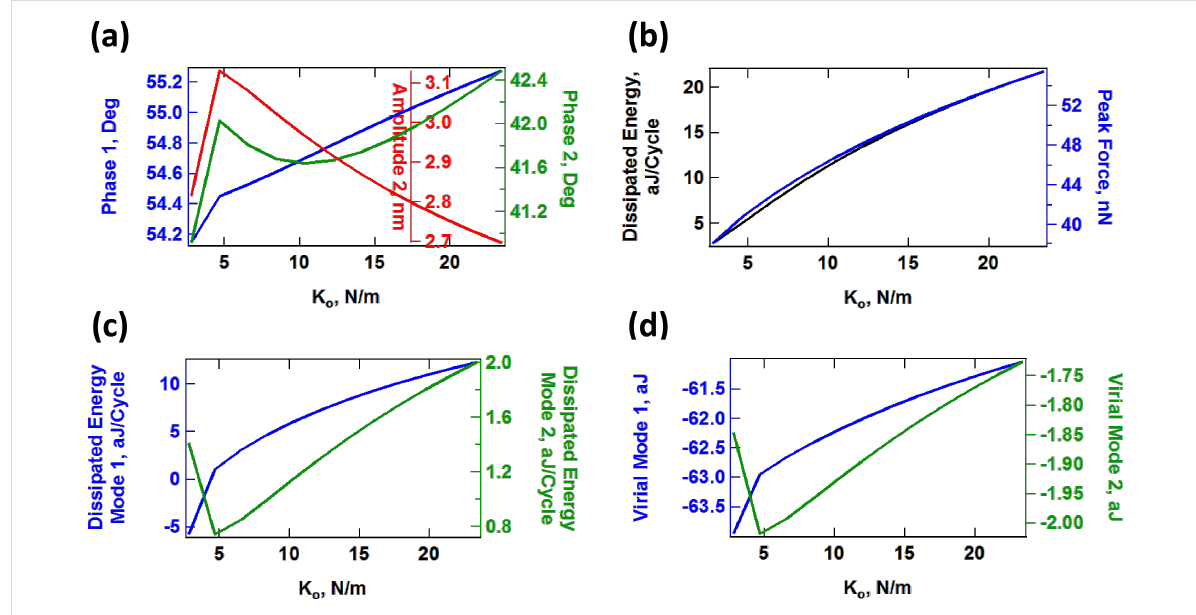
Figure 12: Effect of the SLS parameter K 0 on tip–sample interactions and cantilever response. (a) First and second mode phase, and second mode amplitude; (b) dissipated energy calculated from the hysteresis loop of the tip–sample force trajectory and peak impact force; (c) calculated dissi- pated energy from Equation 5 for the first and second eigenmodes; (d) virial for the first and second eigenmodes. Note that the peak impact force is the largest repulsive force observed over fifteen tip–sample impacts (successive impacts differ, as illustrated in Figure 7c). The parameters other than K 0 are the same used to construct Figure 10. The axes are color coded in all cases. The kinks in some of the traces correspond to transitions between dynamic regimes, in some of which the tip skips a tip–sample impact with different frequencies (for example, in one regime the tip may impact the sample every fundamental oscillation, while in another regime the tip may skip every sixth impact [42]).